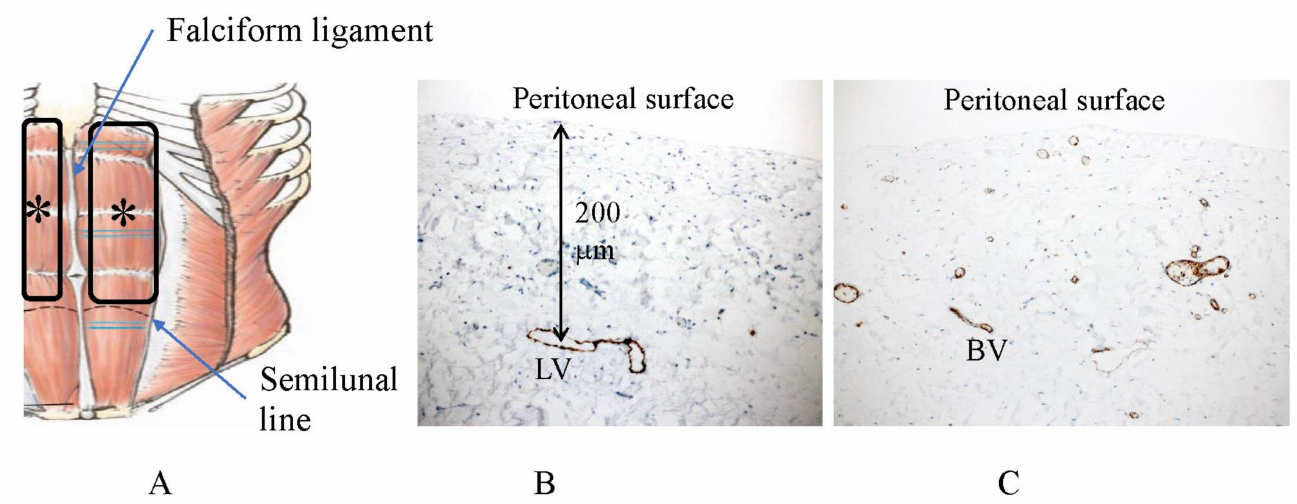
Figure 20. Subperitoneal blood vessels ( C ) in the peritoneum of the anterior abdominal wall ex- tending from the hypochondrium to the semilunal line except the falciform ligament (*) ( A ) (CD31 immunostaining). ( B ) Subperitoneal lymphatic vessels in the peritoneum of anterior abdominal wall (D2-40 immune staining) located 200 µ m below the peritoneal surface. ( C ) Density of submesothelial blood vessels in the anterior abdominal wall is